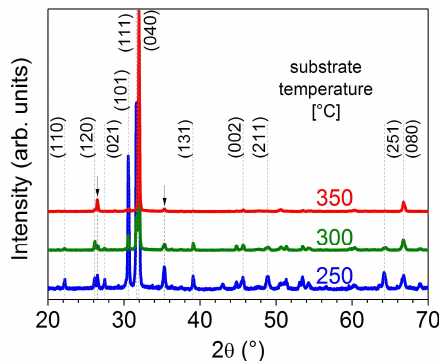
Figure 2. XRD patterns of SnS thin films deposited at different substrate temperatures: 250 °C (blue), 300 °C (green), and 350 °C (red).